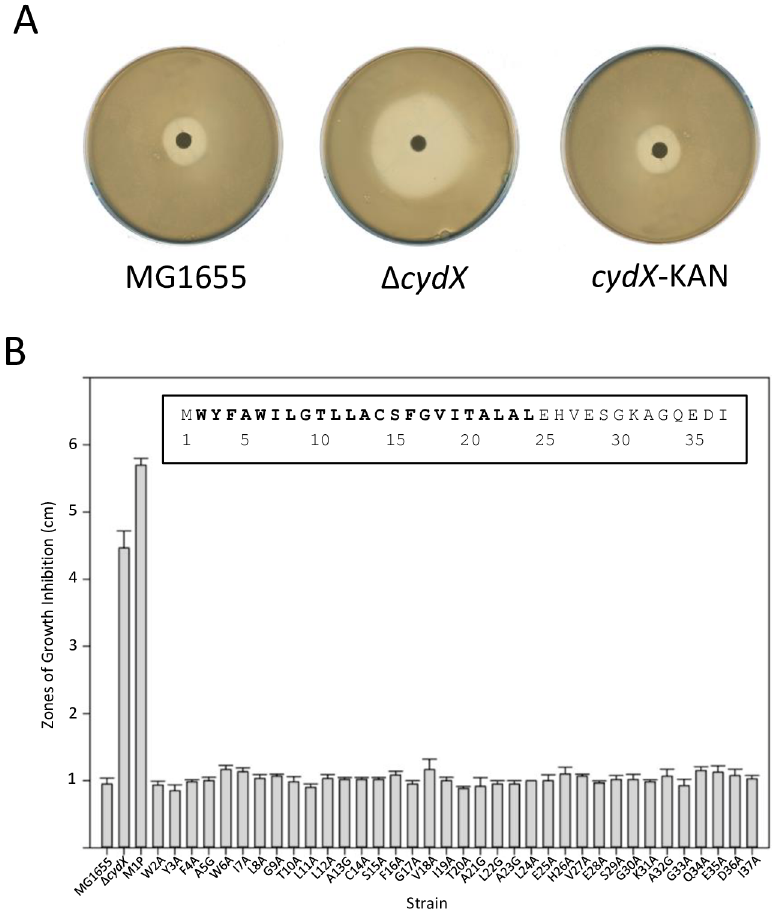
Fig 2. Sensitivity of single amino acid CydX mutants to β -mercaptoethanol. A) Zones of growth inhibition for wild- type, Δ cydX and the cydX +Kantemplate strain used to make the mutants. B) Zones of growth inhibition for each single mutant strain. The E . coli CydX protein sequence is inset. All experiments were performed in at least triplicate, and the standard error of each experiment is shown.